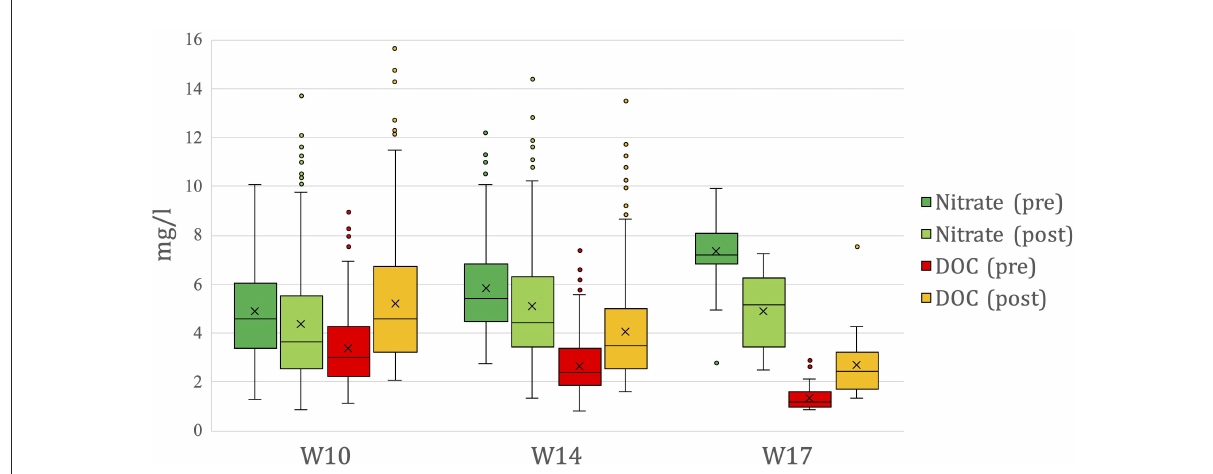
FIGURE3 Boxplots indicating nitrate (green) and DOC (red/orange) concentration measured before and after deforestation. Boxplots indicating the distribution prior to the deforestation are colored with darker shades and post-deforestation boxplots are colored with lighter shades. X is indicative of the